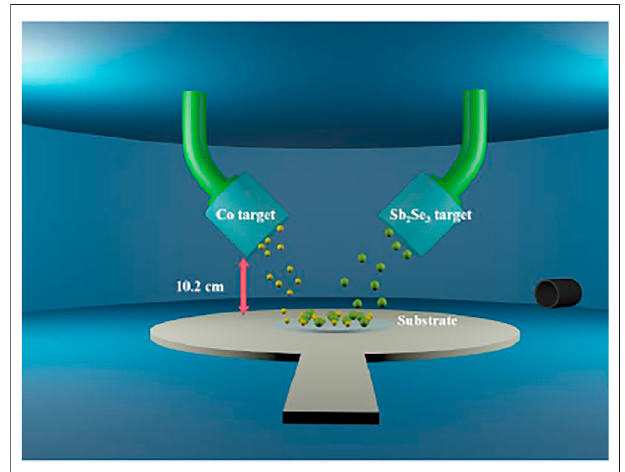
FIGURE 1 | The process of preparing Co-doped Sb 2 Se 3 by using magnetron sputtering